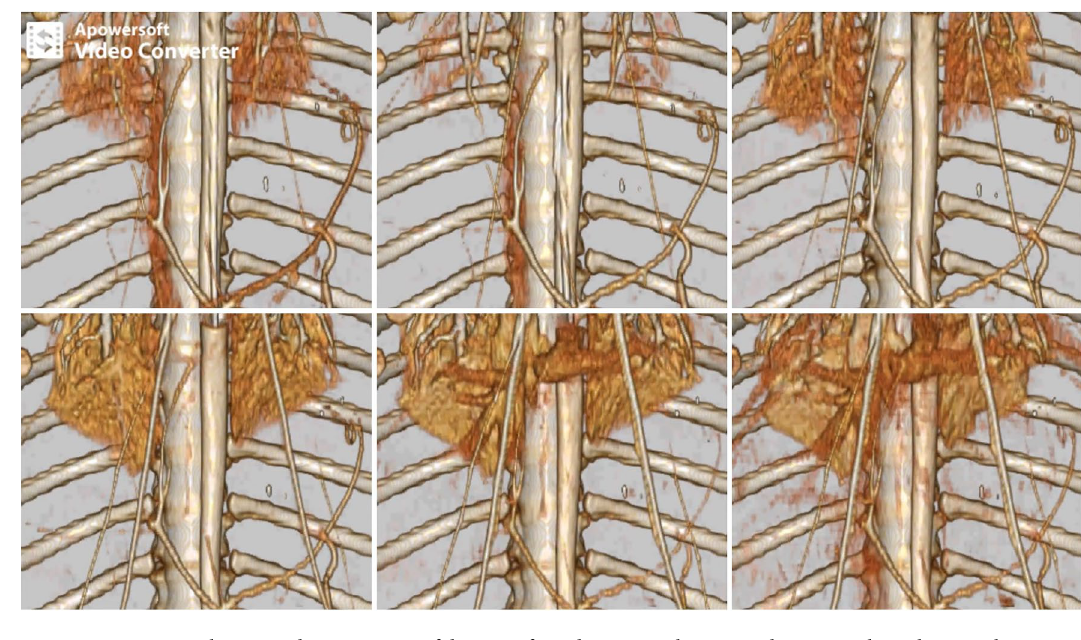
Figure 1. Volume-rendering images of dynamic four-dimensional computed tomography in haemorrhagic shock.